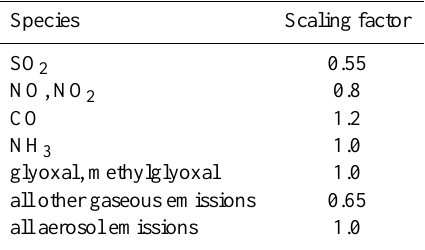
Table 2. Emissions scaling factors (E=E orig · Scaling Factor), for 2010 relative to 2005/2008.